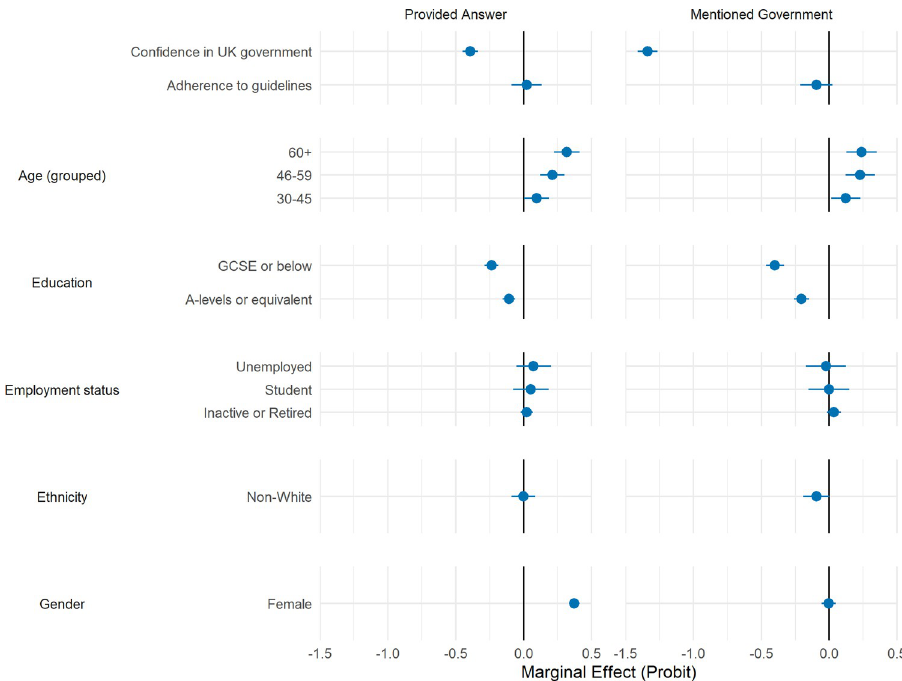
Fig 2. Marginal effect (+ 95% CIs) of participant characteristics and answering free-text questions (left panel) or mentioning government in free-text questions (right panel). Estimates derived from probit model (left panel) and Heckman’s selection probit model (right panel) with simultaneous adjustment for participant characteristics. Heckman’s selection model include each characteristic in both the selection and outcome parts of the model.